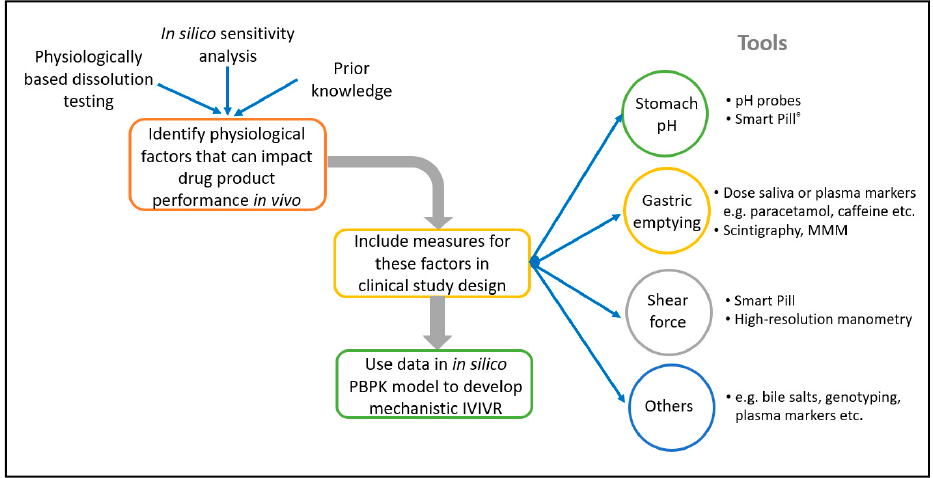
Figure 1. Opportunities for characterisation of the gastrointestinal environment in individual subjects in formulation studies.